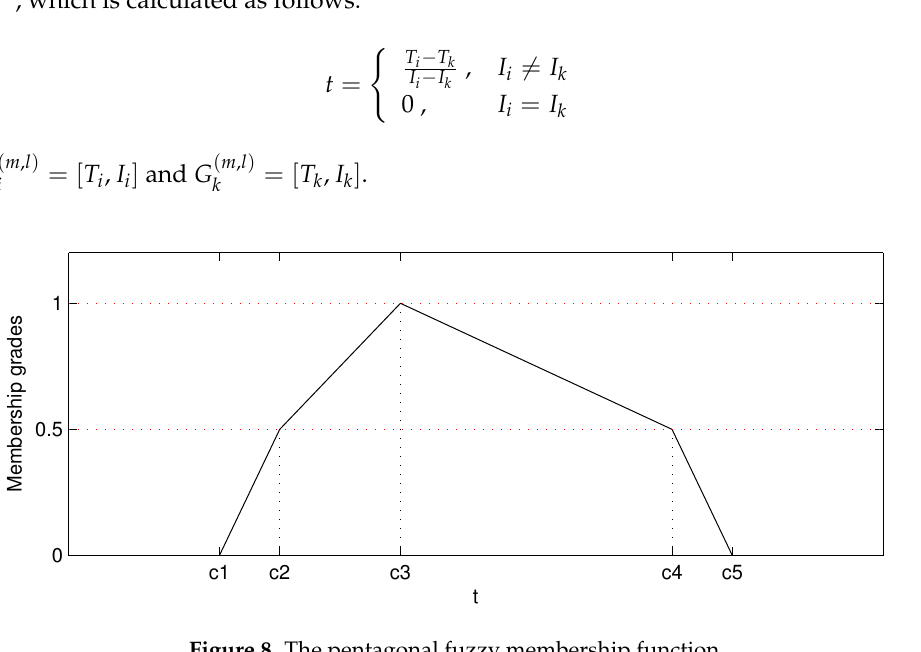
Figure 8. The pentagonal fuzzy membership